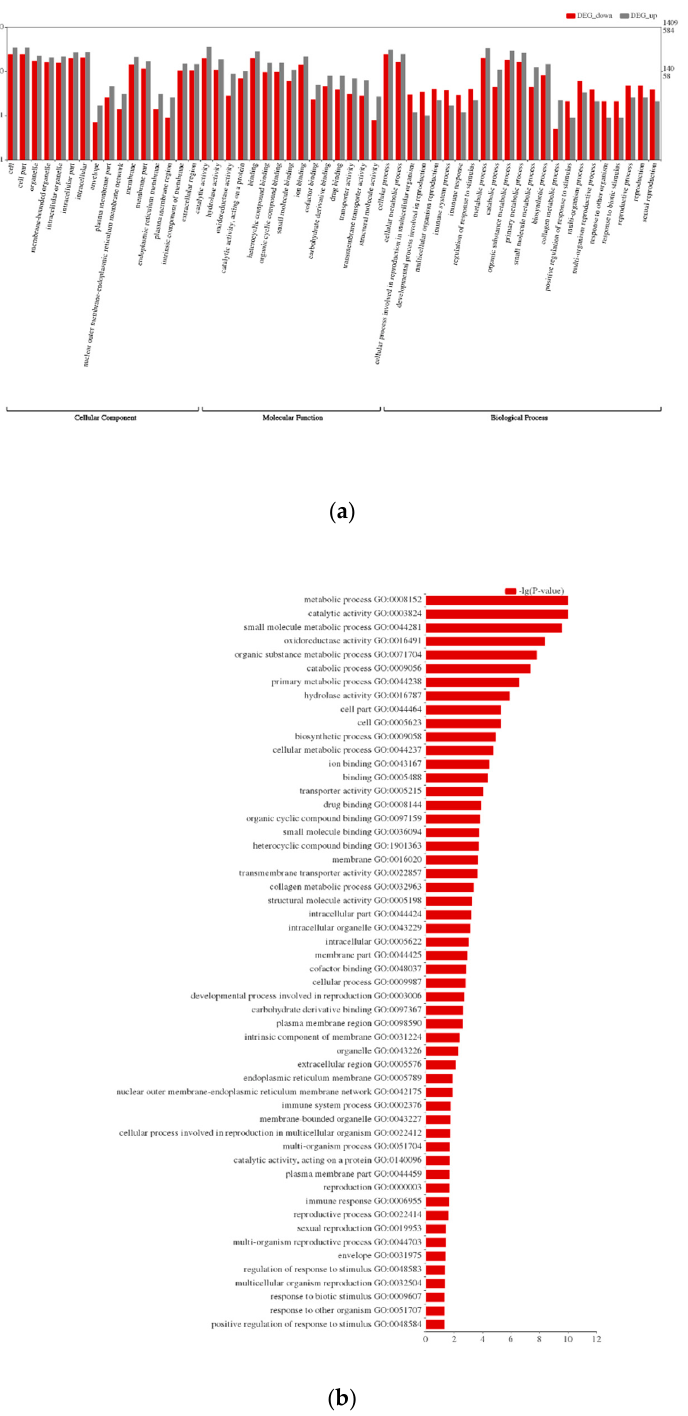
Figure 2. Gene ontology (GO) classification of the Papilio xuthus transcriptome. ( a ) The GO was summarized into three main categories: biological process, cellular component, and molecular function. x -axis indicates the sub-categories of GO terms, and the y -axis indicates percentage and number of unigenes on the left and right side, respectively. ( b ) Top fitting GO subcategories were displayed.